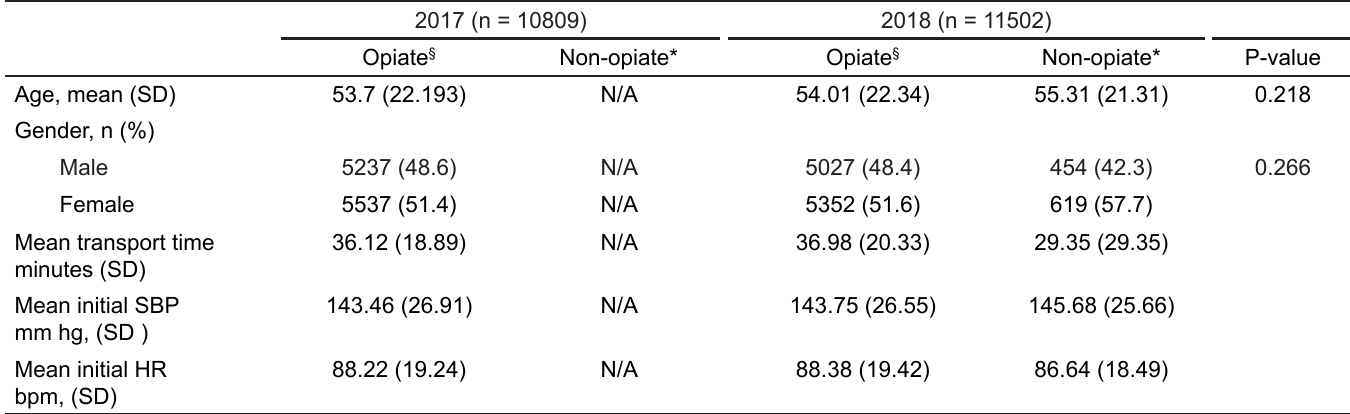
Table 1. MATRIS + patient